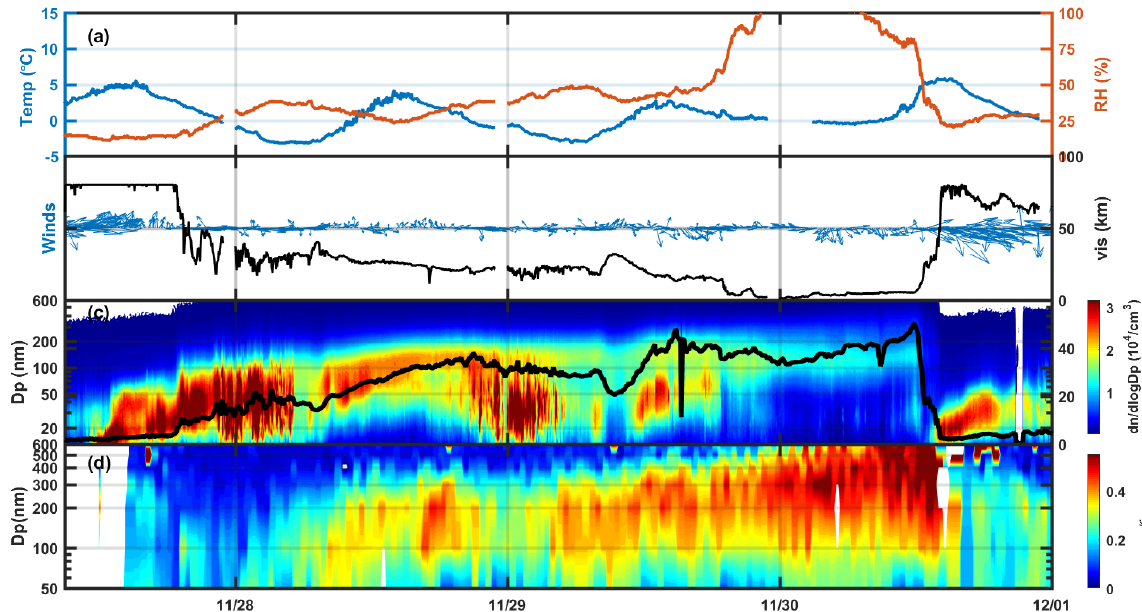
Figure 7. A pollution cycle from 27 November to 1 December 2019. Panel (a) is the temporal evolution of temperature (blue line) and RH (orange line); (b) is the time series of visibility (black line) and winds. The length of the arrow indicates the wind speed, and the direction of the arrow indicates the wind direction. Panel (c) shows the time series of particle number size distribution, and the black line is the integrated volume concentration. The left axis is the log scale of particle diameters, and the right axis is for the volume concentration. Panel (d) is the size-resolved hygroscopicity parameter κ .